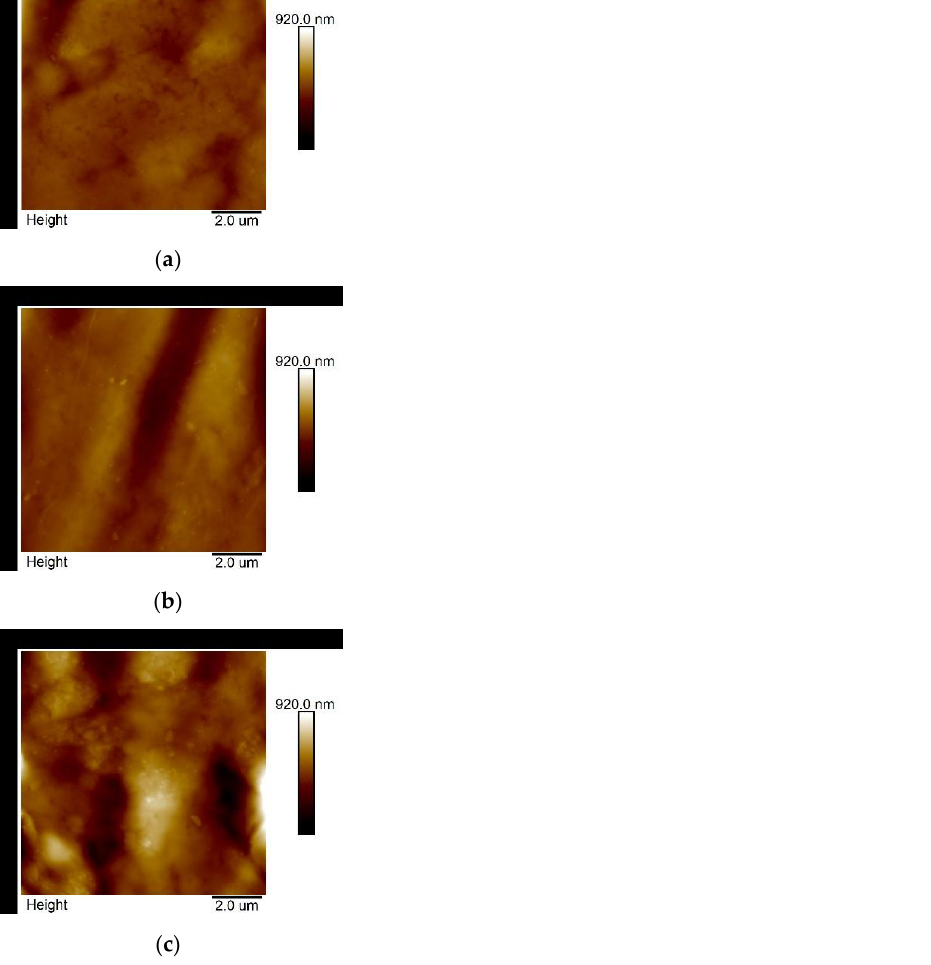
Figure 3. The representative map of topography (10 × 10 μm) for samples k0 ( a ), k5 ( b ), k10 ( c ).